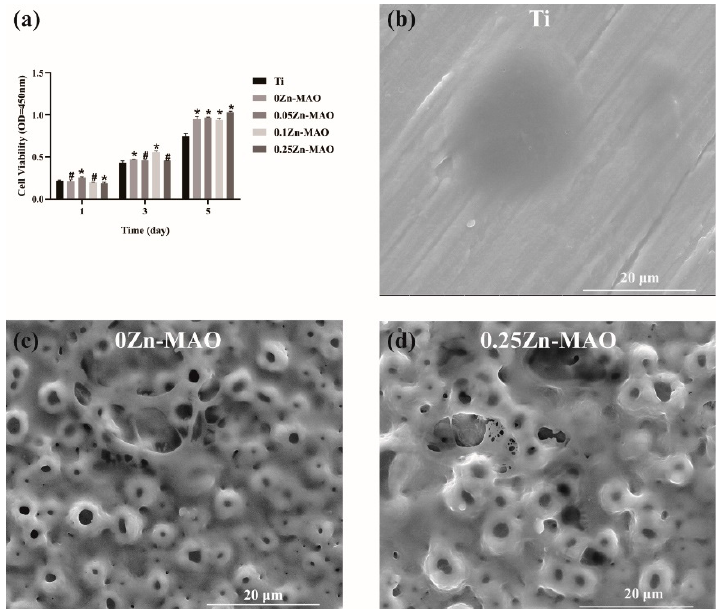
Figure 5. The cell biocompatibility of Zn-MAO ( a ). Cytotoxicity was measured after 1, 3, and 5 days of culture. The BMSCs morphologies on Ti ( b ), 0Zn ( c ), and 0.25Zn ( d ) groups surface for 3 days under SEM. Data are presented as mean ± SD; (* p < 0.05, # p > 0.05, vs. Ti group).